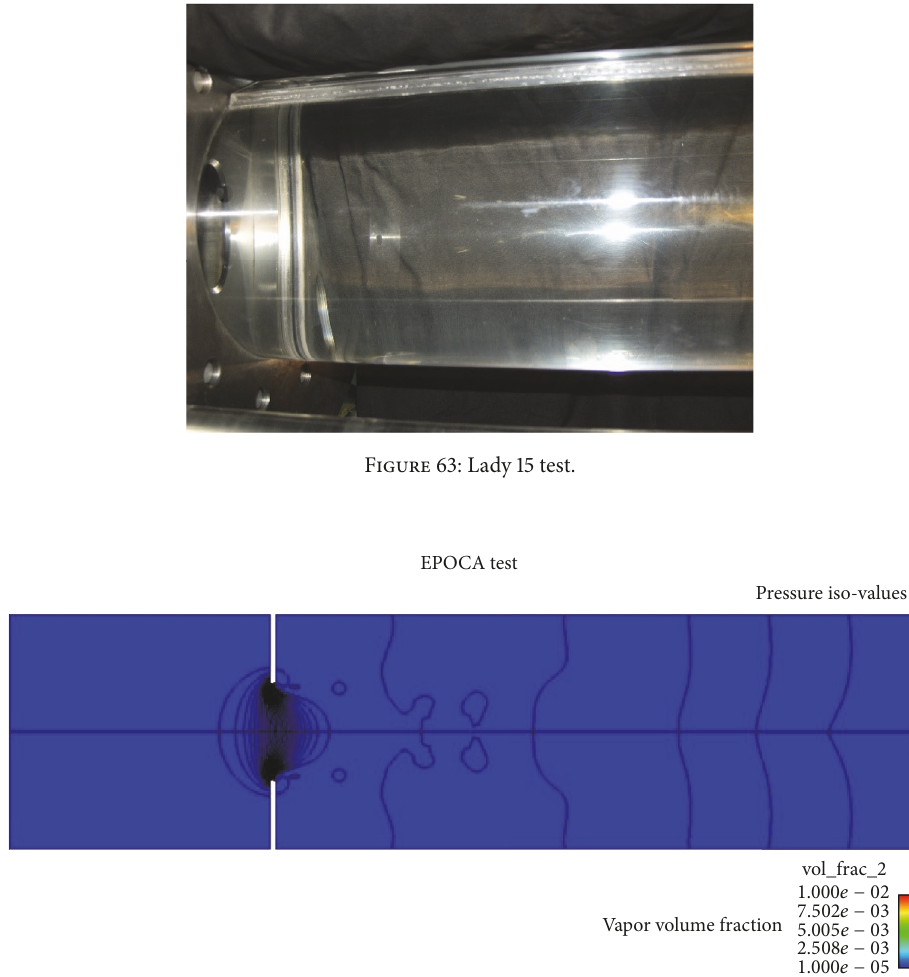
Figure 64: Lady 15 test: two-dimensional representation of the pressure and void fraction calculated by the CFD code (see Figure